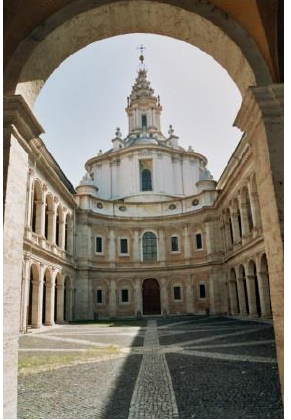
Fig. 19 Sant’Ivo alla Sapienza, Rome (Borromini, 1662)